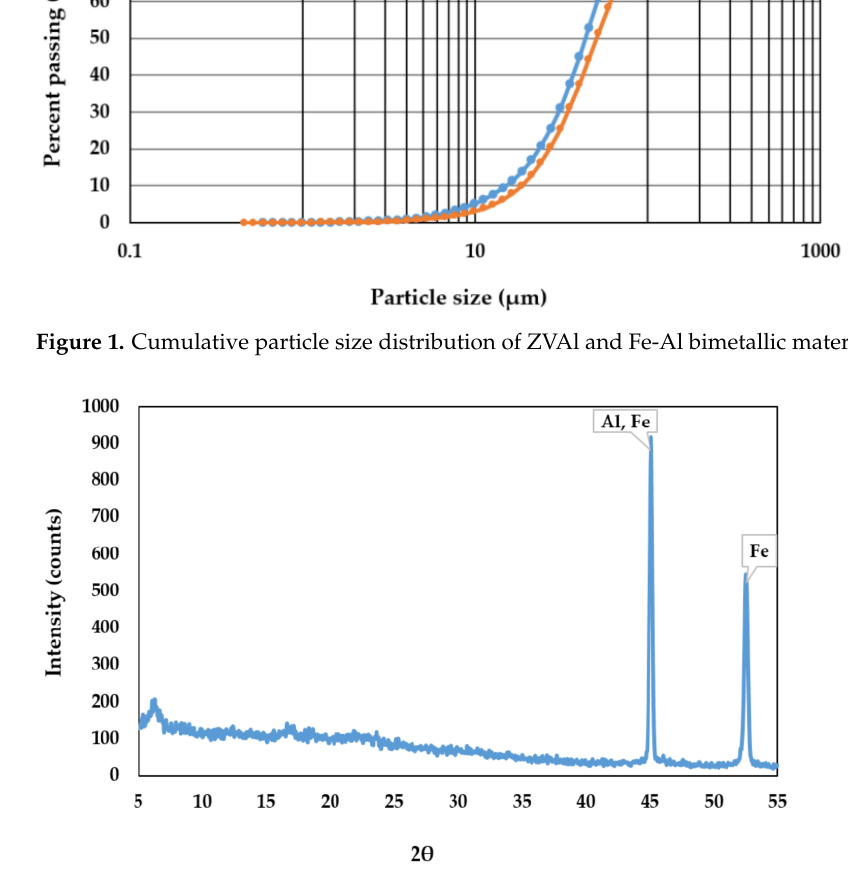
Figure 2. XRD pattern for the synthesized Fe-Al bimetal.